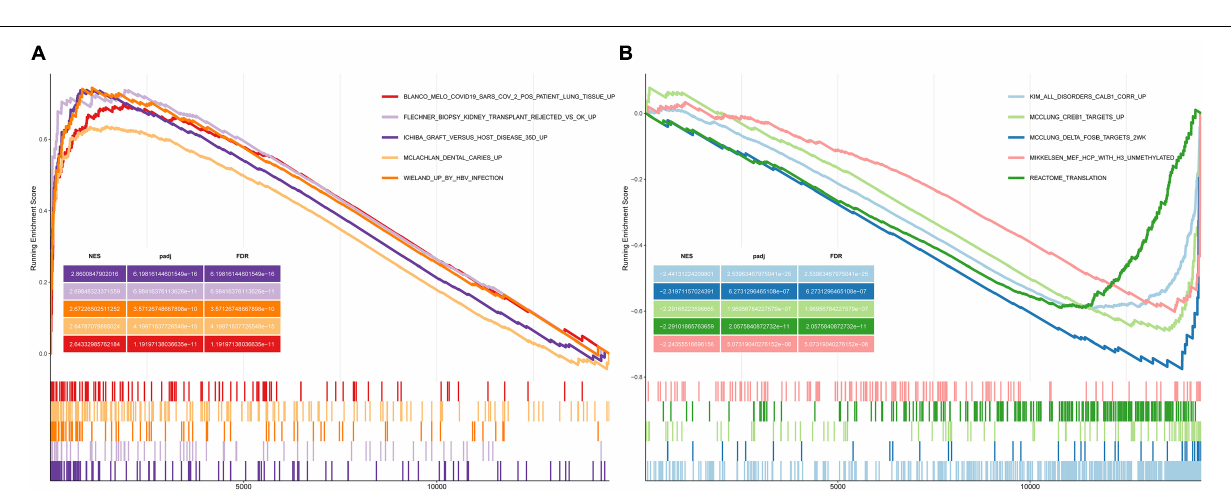
Frontiers in Medicine |